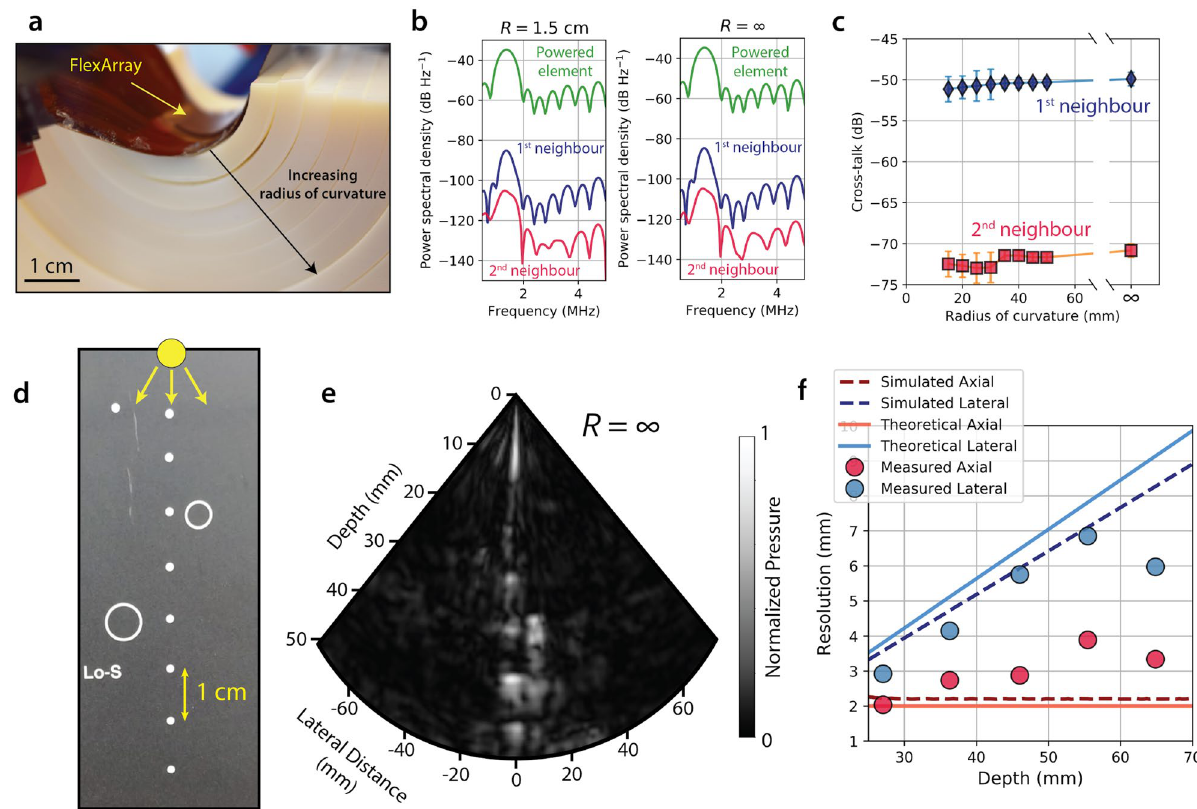
Figure 4. Cross-talk characterisation between neighbouring elements and medical-grade flat phantom imaging. ( a ) Photograph of the detachable 3D-printed apparatus for the testing of electrical cross-talk across different radii of curvature. ( b ) Power spectra of the voltage response of a single powered transducer (green), relative to those of its nearest neighbour element (blue) and its second nearest neighbour (pink). Extreme cases of a highly-curved array ( R = 1.5 cm) and a flat array ( R = ∞) are compared. ( c ) Cross-talk between neighbouring elements, extracted at 1.4 MHz, as a function of radius of curvature of the FlexArray. The device shows excellent inter-channel shielding characteristics at high operational frequencies, regardless of shape. ( d ) Photograph of the cross-section of the tissue phantom with embedded nylon wires (white dots). The yellow dot marks the vertical location where the FlexArray was placed during imaging. ( e ) B-mode scan of the phantom taken with the FlexArray, demonstrating both its axial and lateral resolution. The locations of the nylon rods can